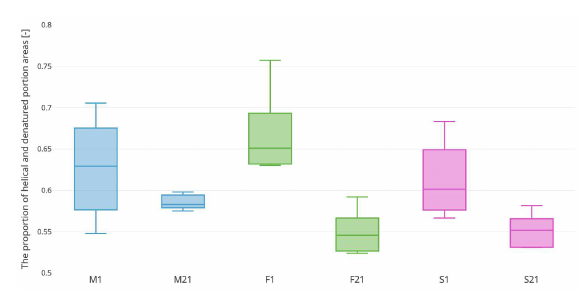
Figure 7. Box plot comparing ratio of helical and denatured areas of collagen (1660 / (1630 + 1615)) 1. day (M1) and 21. (M21) day of samples exposed in medium, 1. (F1) and 21. day (F21) of fibroblast, 1. (S1) and 21 (S21) of osteoblast samples